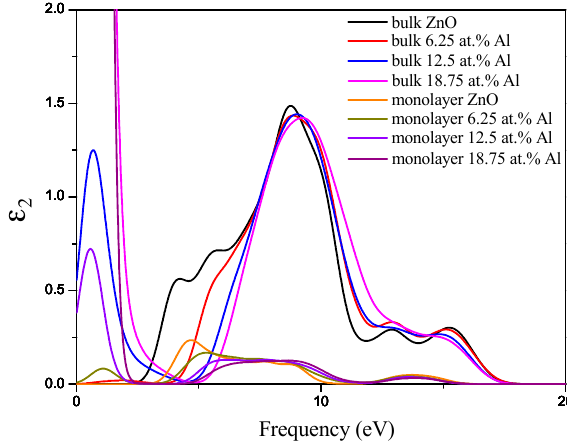
Figure 6. The imaginary part of the dielectric function of ZnO bulk and monolayer doped with different Al concentrations.